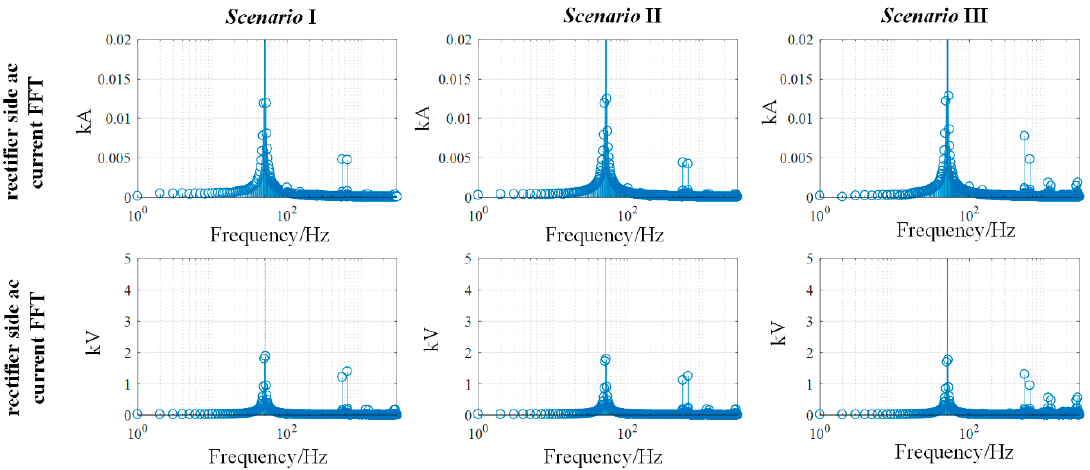
Figure 16. FFT results of ac current and voltage.